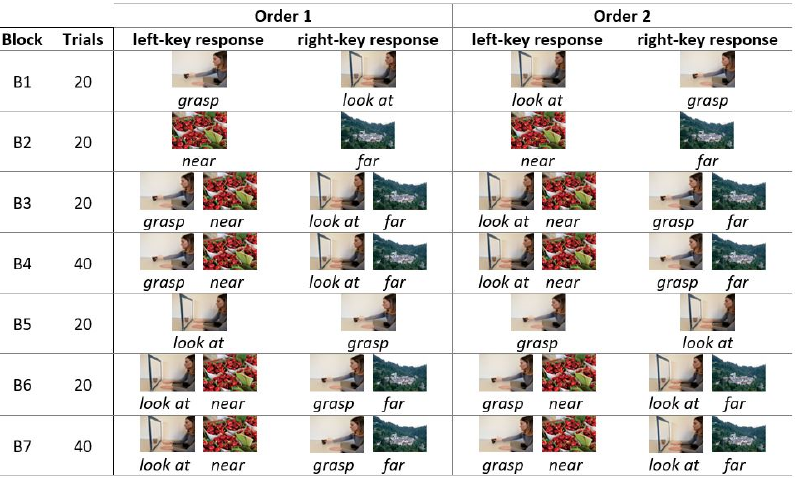
Figure 1. Examples of trials in congruent ( left panel ) and incongruent ( right panel ) blocks of Ex ‐ periment 1. Participants were asked to press the E key with their left hand, when the category to which the image belongs was written at the top left, and to press the I key with their right hand, when it was written at the top right (see the text for details).